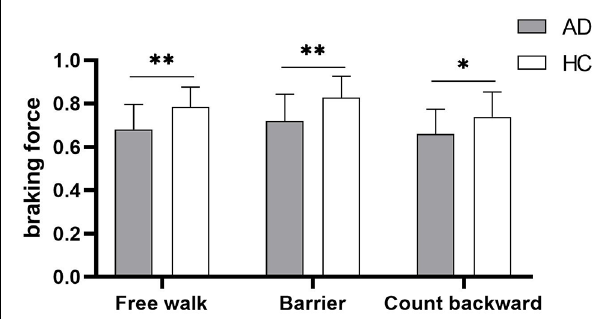
FIGURE 1 | The comparison of braking force between patients with Alzheimer disease (AD) and healthy controls (HCs) in the walking of Free walk, Barrier, and Count backward. ∗ P < 0.05, ∗∗ P < 0.001.